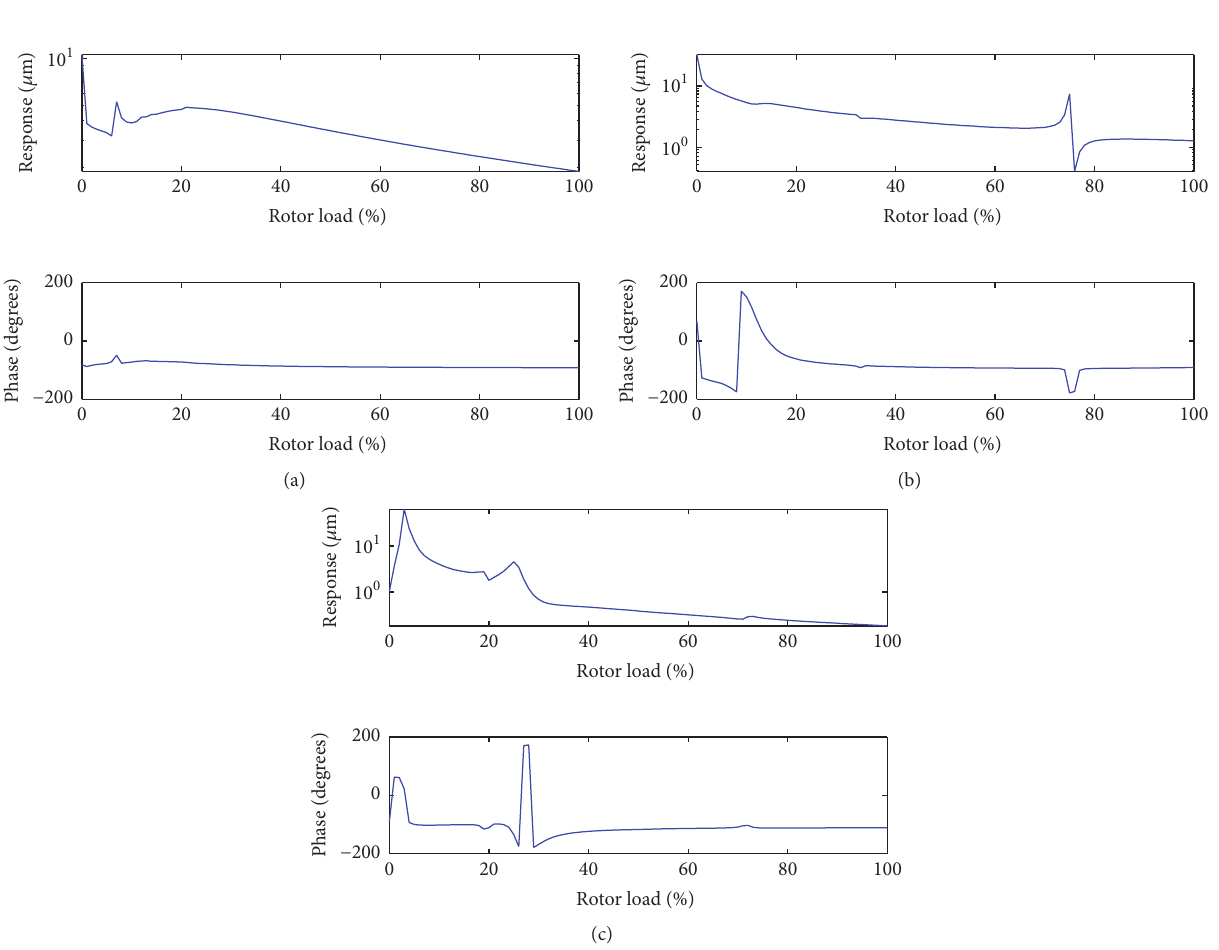
phenomenon occurs in O2 and O3 when they are at the rated